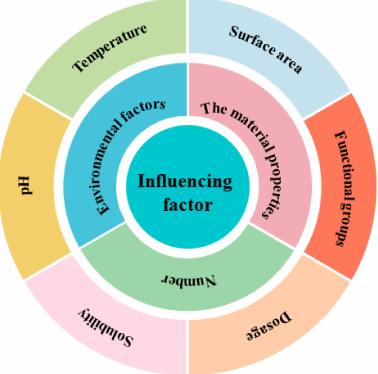
Figure 4. Different types of influencing factors in the process of adsorbing pollutants by